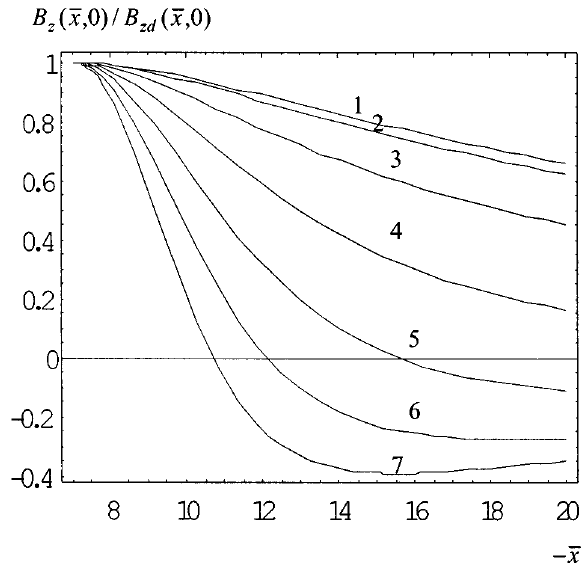
Fig. 2. Variation of the dimensionless field component B z (x, 0 )/B zd (x, 0 ) along the sheet. Numbers at the curves corre- spond: γ 1 = − 1 . 5, γ 2 = − 2 . 0, γ 3 = − 2 . 5, γ 4 = − 3 . 0, γ 5 = − 3 . 5, γ 6 = − 4 . 0, γ 7 = − 4 .